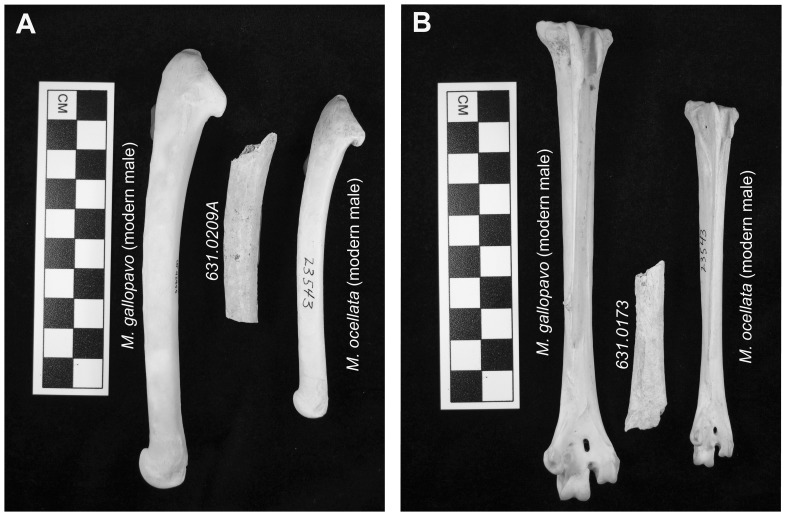
Archaeological turkey specimens compared with modern M. gallopavo and M. ocellata: A) right ulnae, and B) left tarsometatarsi.